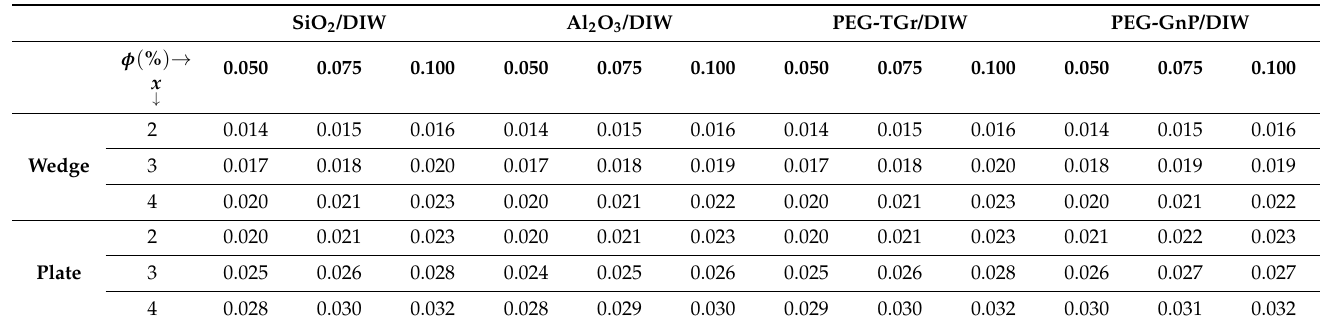
Table 11. Displacement thickness 10 × δ ∗ of schematic nanofluids over the wedge and plate at different nanoparticle volume fractions.